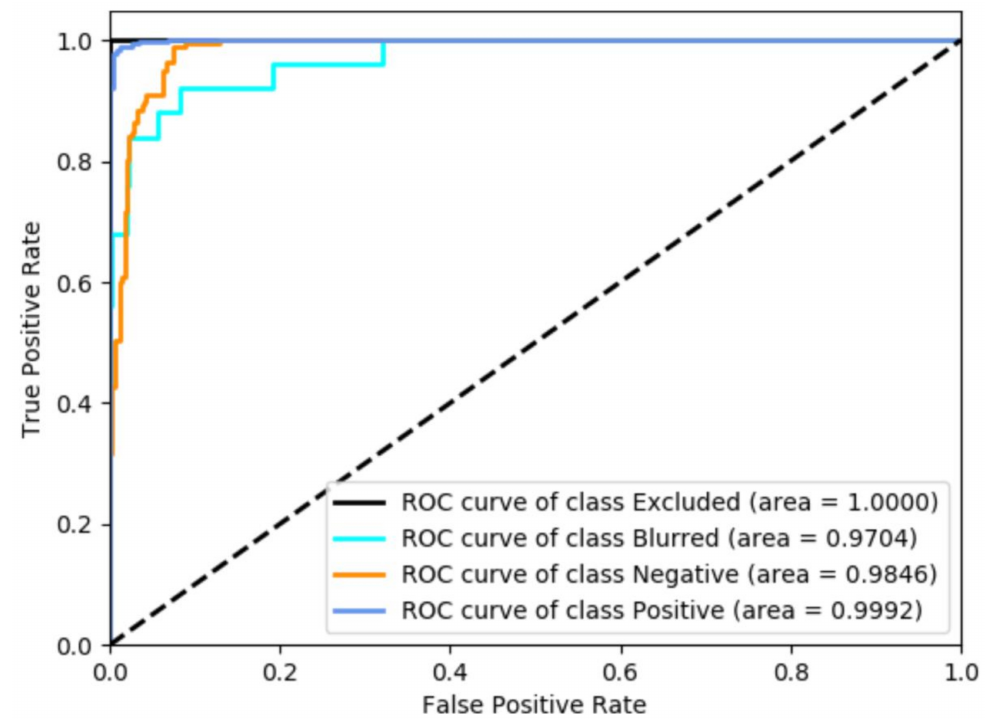
Figure 4. Receiver operating characteristic (ROC) curves of the four categories. Class positive = retained nuclear BAP1 expression. Class negative = lost nuclear BAP1